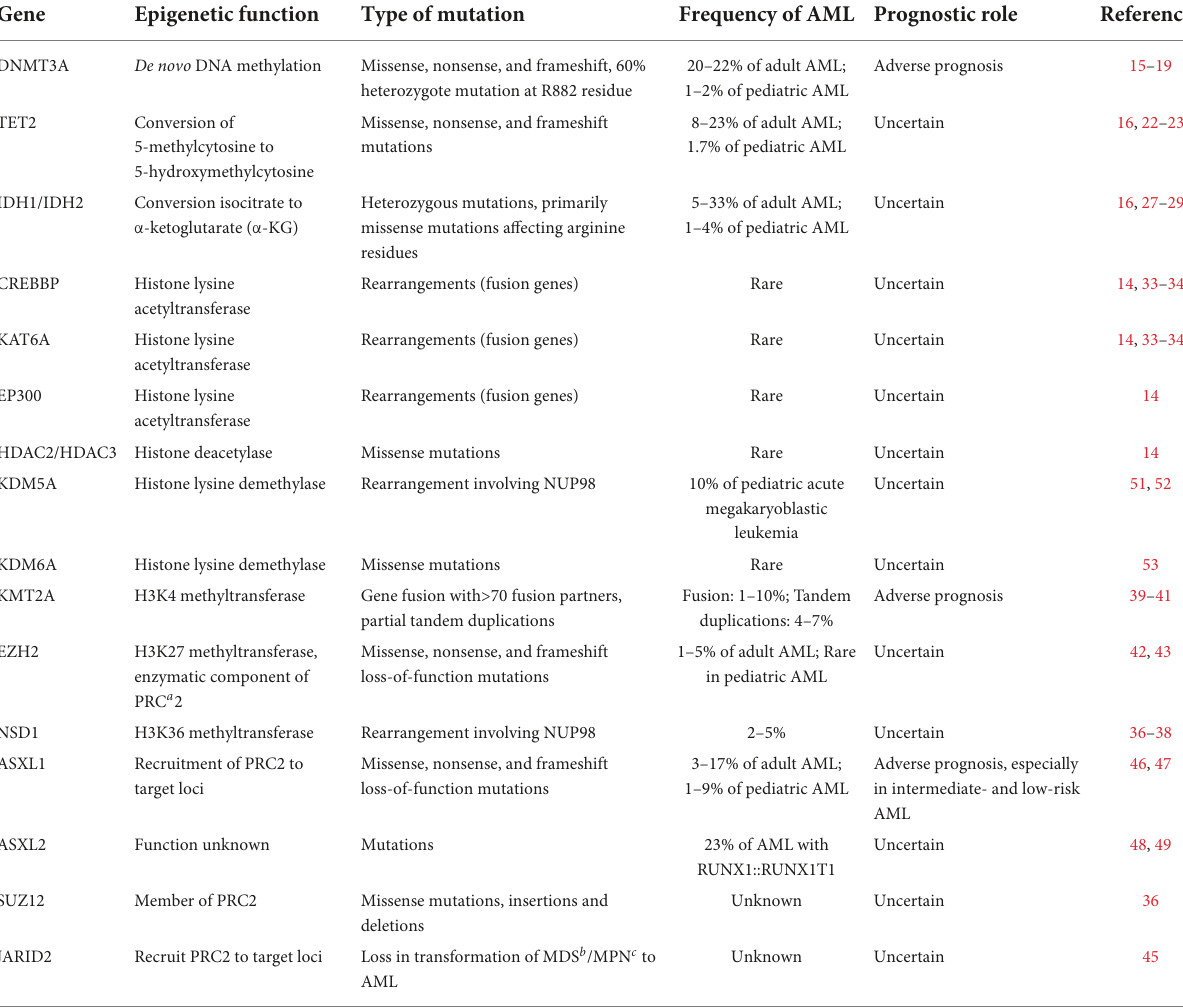
TABLE 1 Recurrently mutated or translocated genes in epigenetic modification in adult and pediatric